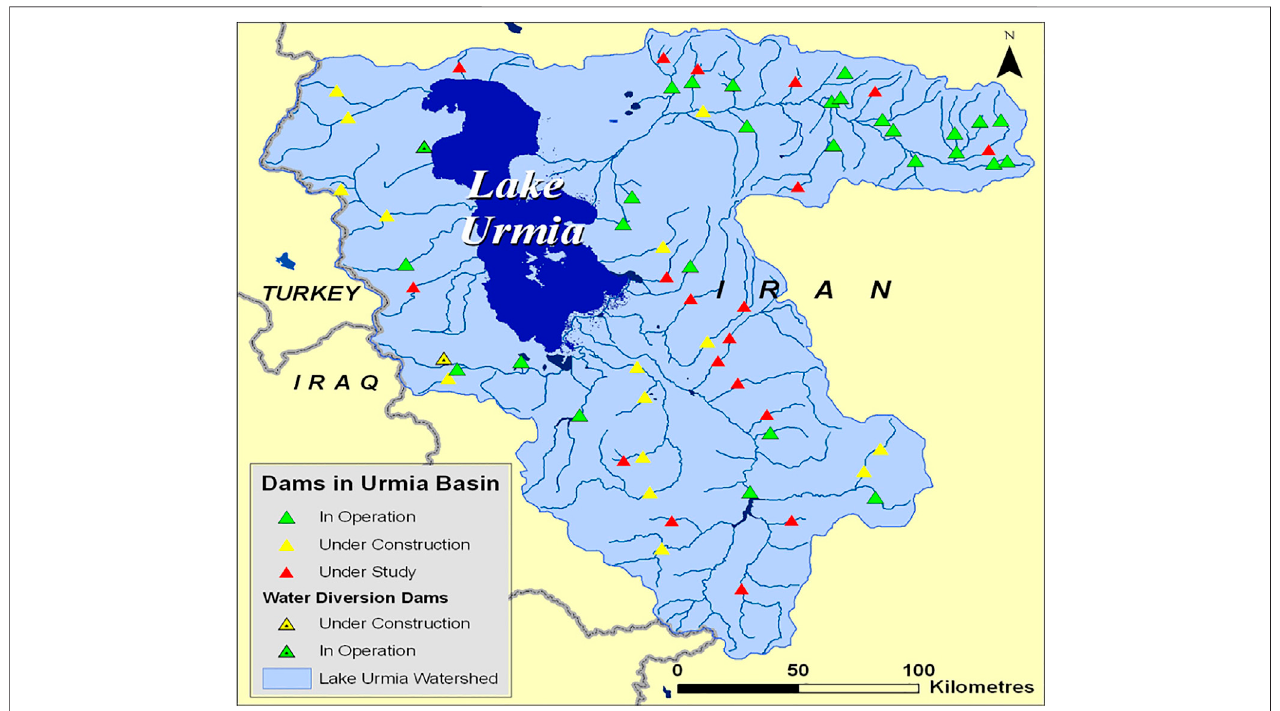
FIGURE 7 | The dams in LU catchment (Hassanzadeh et al., 2011).